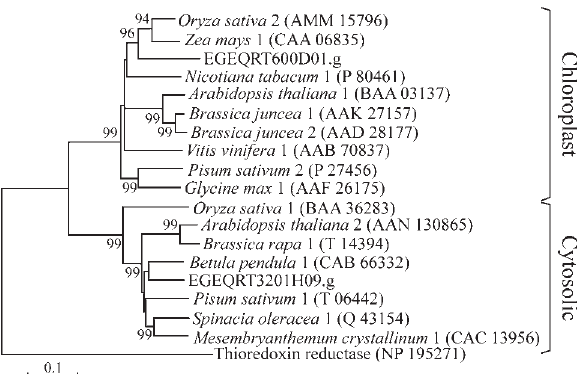
Figure 7 - Phylogenetic tree of GR proteins. Phylogenetic analyses were conducted as described in Figure 2.